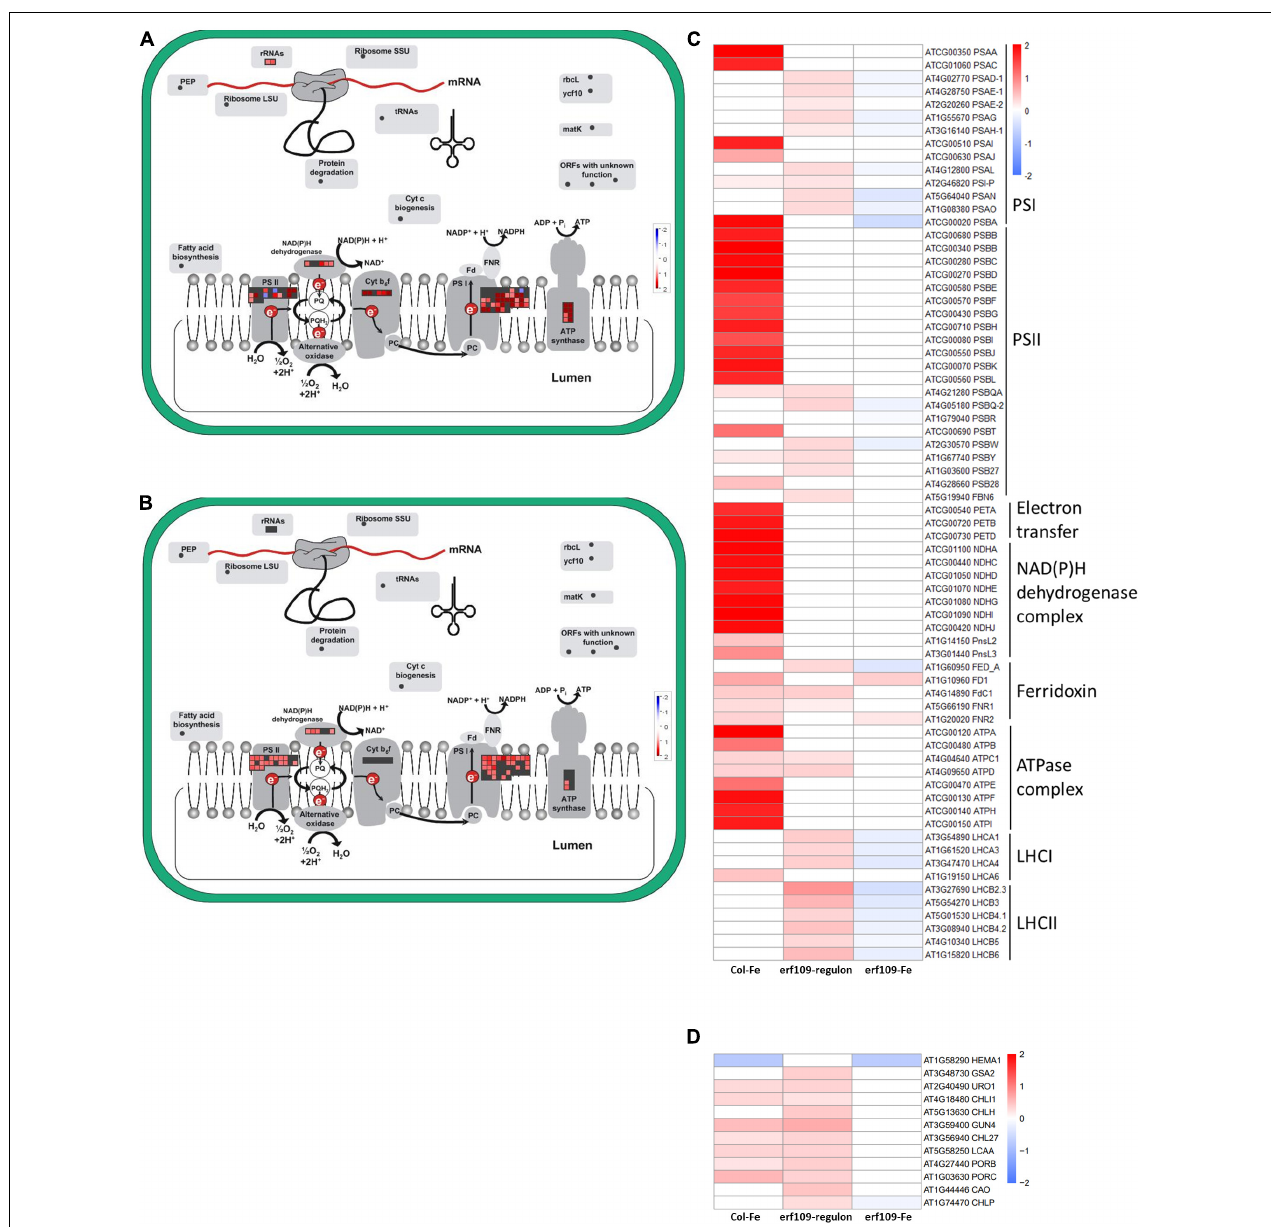
FIGURE 5 | Differentially expressed genes encoding photosynthesis-related proteins. (A) Col-Fe, (B) erf109 -regulon. Graphs were generated with MapMan software (Thimm et al., 2004). Heatmap depicting log2 fold-changes of genes encoding photosynthesis subunits (C) and genes involved in chlorophyll biosynthesis (D) in group 2. Log2-fold changes of DEGs are labeled by color: white, no significant changes; red, up-regulated; blue,